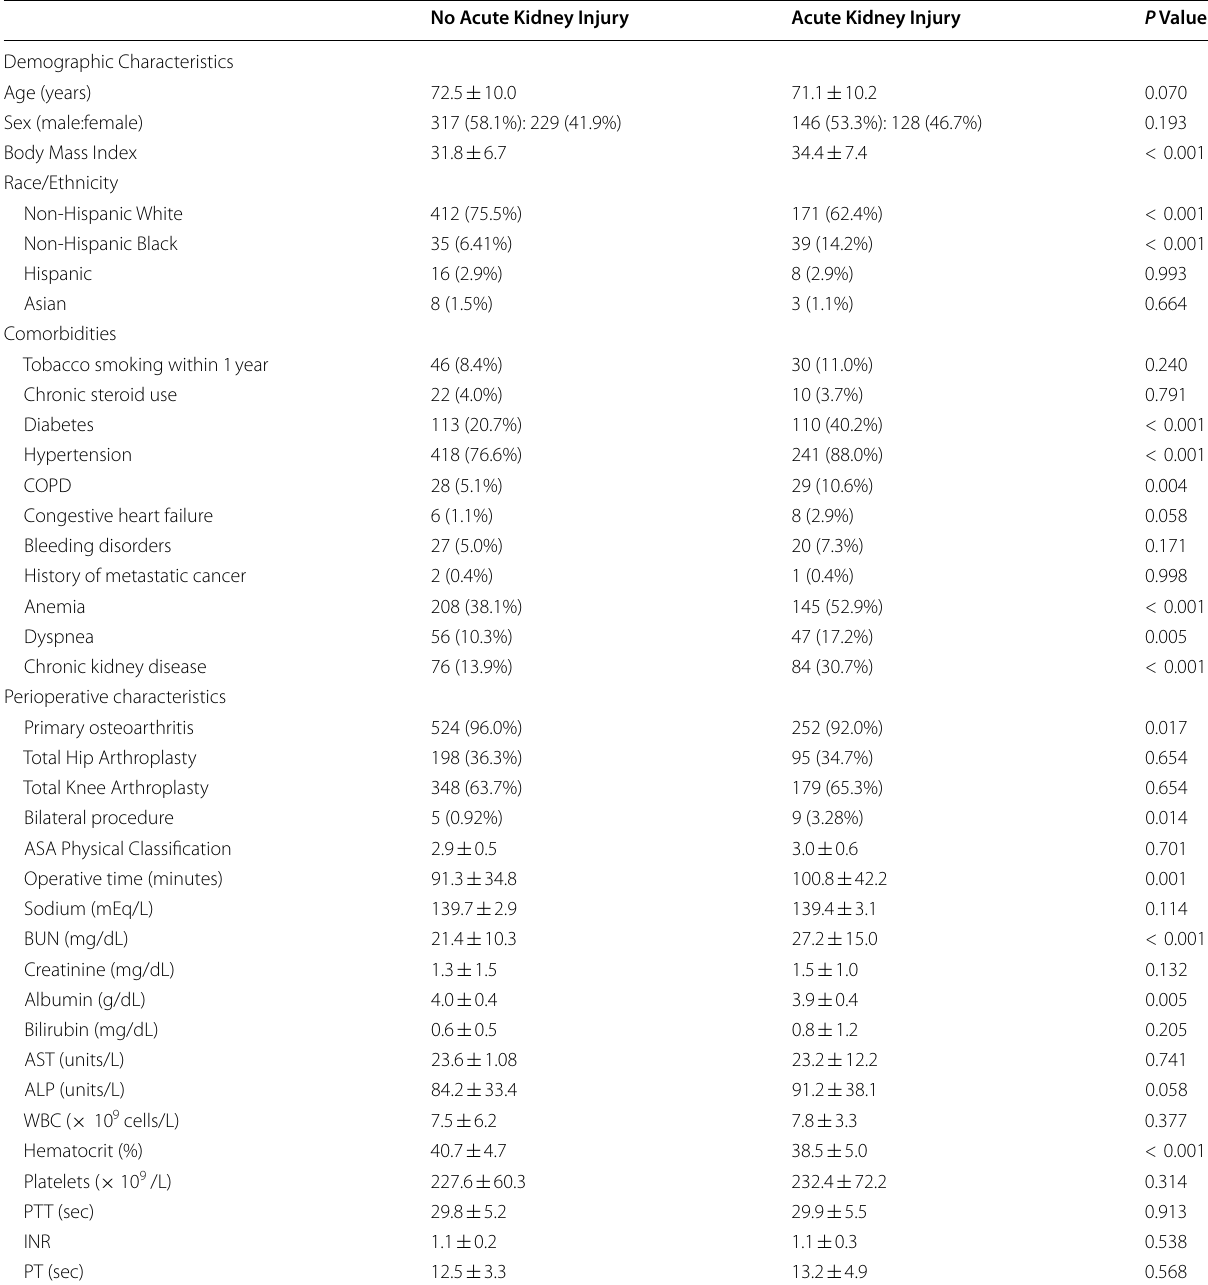
ALP Alkaline phosphatase, ASA American Society of Anesthesiologists, BUN Blood urea nitrogen, CHF Congestive heart failure, CKD Chronic kidney disease, COPD Chronic obstructive pulmonary disease, INR International normalized ratio, PTT Partial thromboplastin time, PT Prothrombin time, WBC White blood count